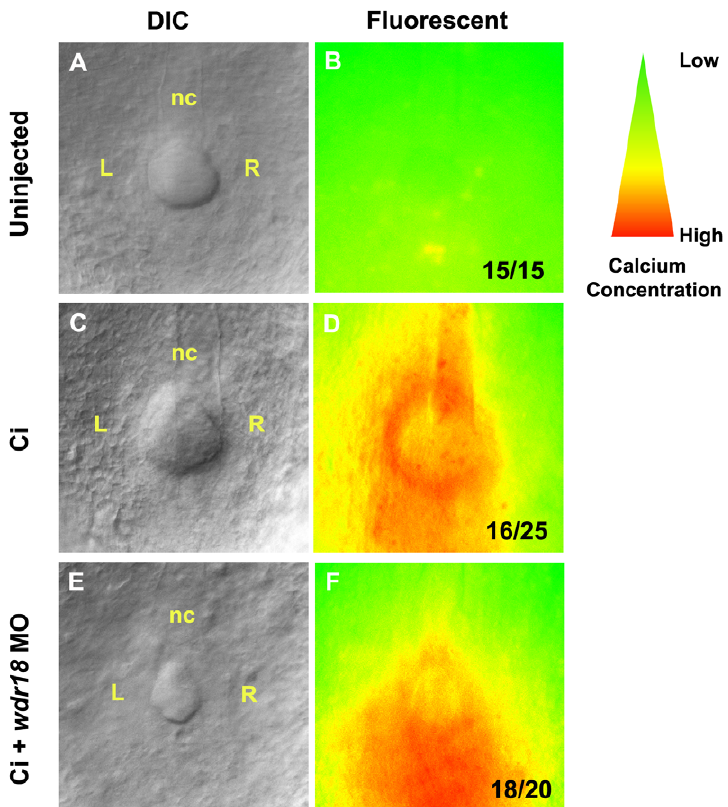
Figure 5. Correct Ca 2 + distribution in the KV during early somite stages requires wdr18 . (A–F) Embryos were injected at the 1-cell stage with Ca 2 + indicator (Ci) or co-injected with wdr18 MO1. Ca 2 + patterns at the 5- to 8-somite stage were imaged by fluorescence microscopy and the images were converted to an intensity scale (colors from red to green indicate intensity from high to low). (A, B) The autofluorescent image of an un- injected control embryo (B) with its corresponding DIC image (A). (C, D) A control embryo injected with Ca 2 + indicator only, showing fluorescence in the KV with elevated signals on the left side. (E, F) An embryo co-injected with Ca 2 + indicator and wdr18 MO1. The KV is smaller and the fluorescence signal is evenly distributed throughout the KV. nc: notochord. The ratio shown in the lower right corner of B, D and F indicate the number of defective embryos versus total embryos.